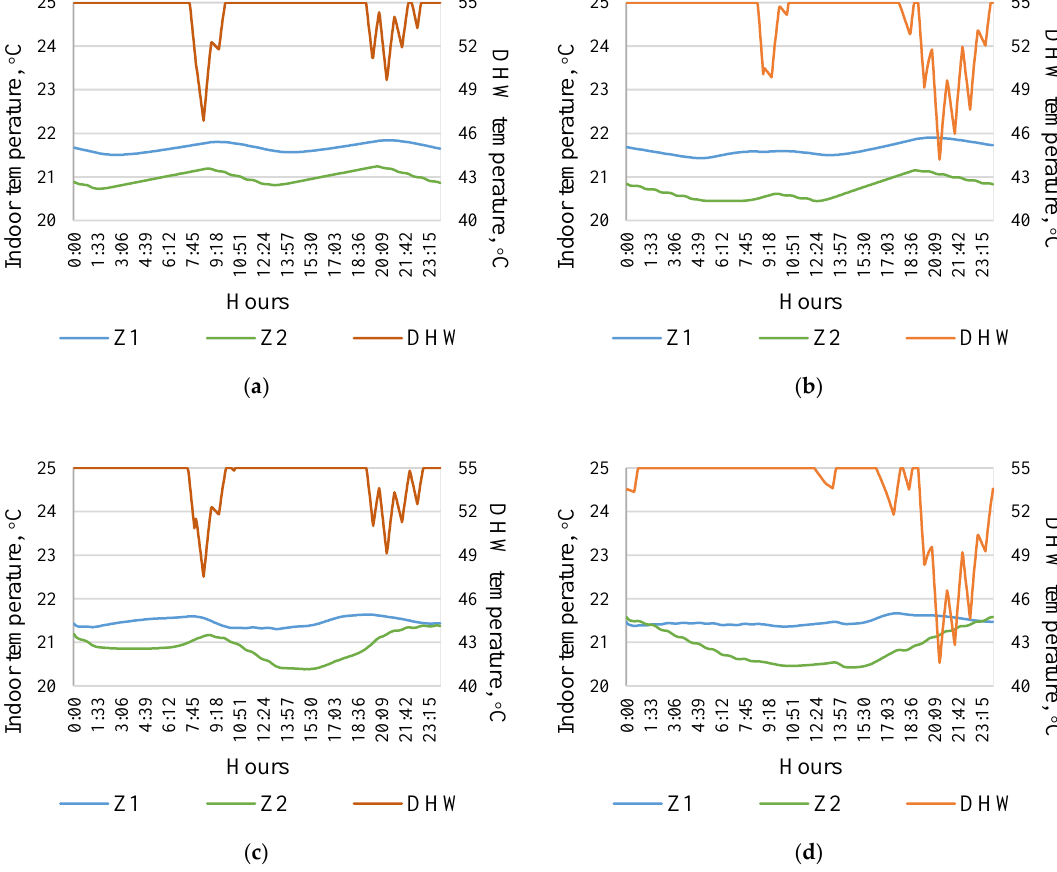
Figure 15. Indoor temperature and DHW outlet temperature for ( a ) a single-family house occupied by 4 people, ( b ) a single-family house occupied by six people, and indoor temperature and DHW supply temperature when internal gains were considered for ( c ) a single-family house occupied by 4 people, ( d ) a single-family house occupied by six people.